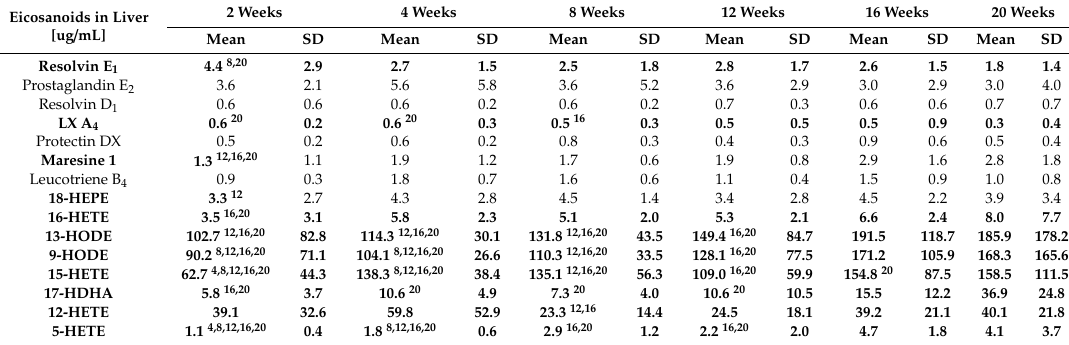
Table 3. Liver eicosanoids concentration during NAFLD